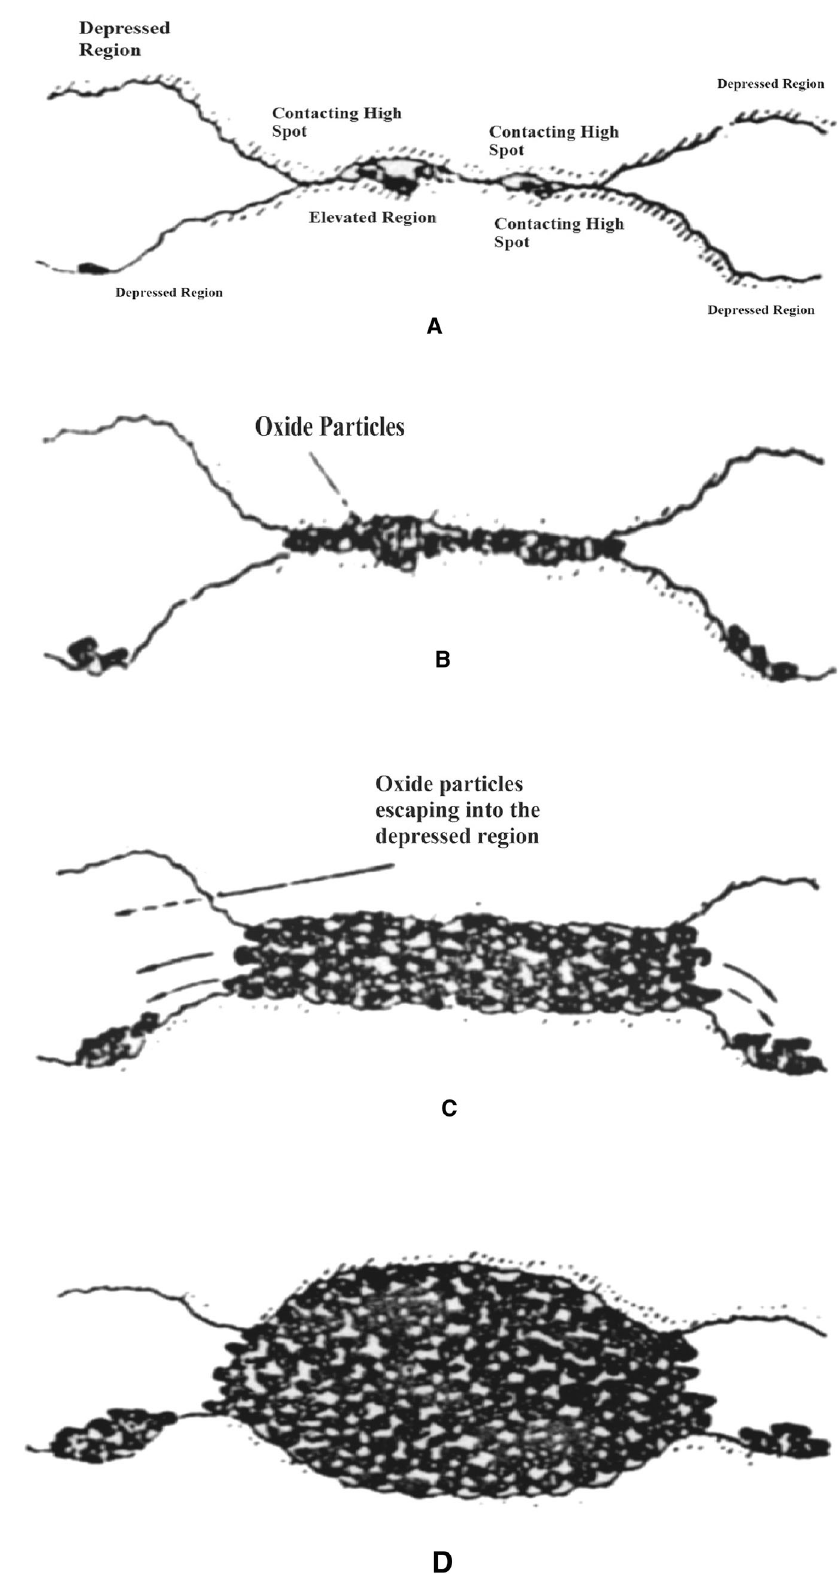
Fig. 12 Various stages of fretting wear, a accumulation of trapped particles in the space between high spots, b integration of contact areas into a united area, c spalling of particles into the adjoining depressed regions, d formation of the curved zone in the middle of the contact area caused by the intense